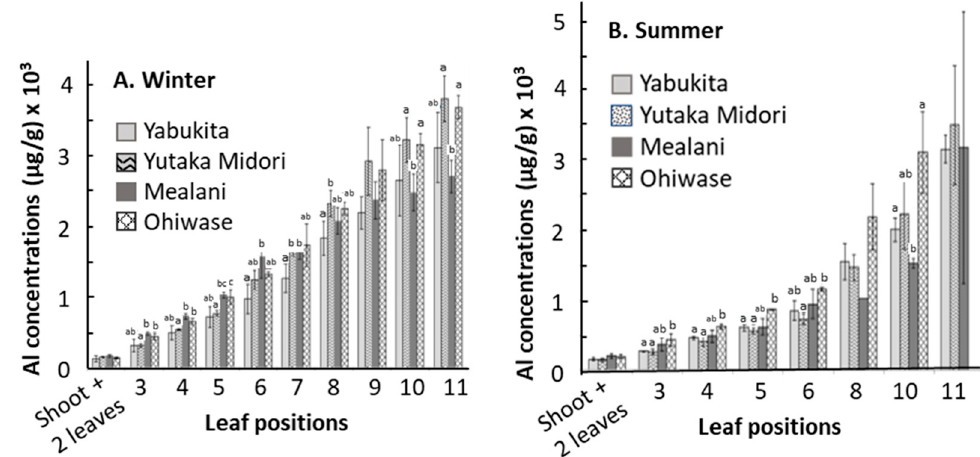
Figure 3. Comparison of Al concentration in winter ( A ) and summer ( B ) tea leaves among four cultivars at specific leaf positions. Different lower letters indicate statistically significant at p ≤ 0.05.